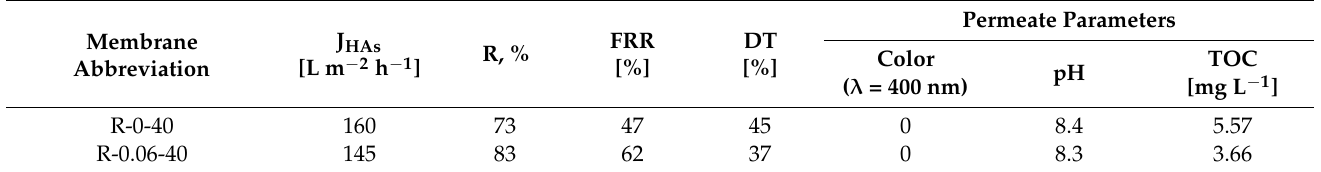
Table 5. HAs solution flux, antifouling parameters and permeate characteristics of reference and modified